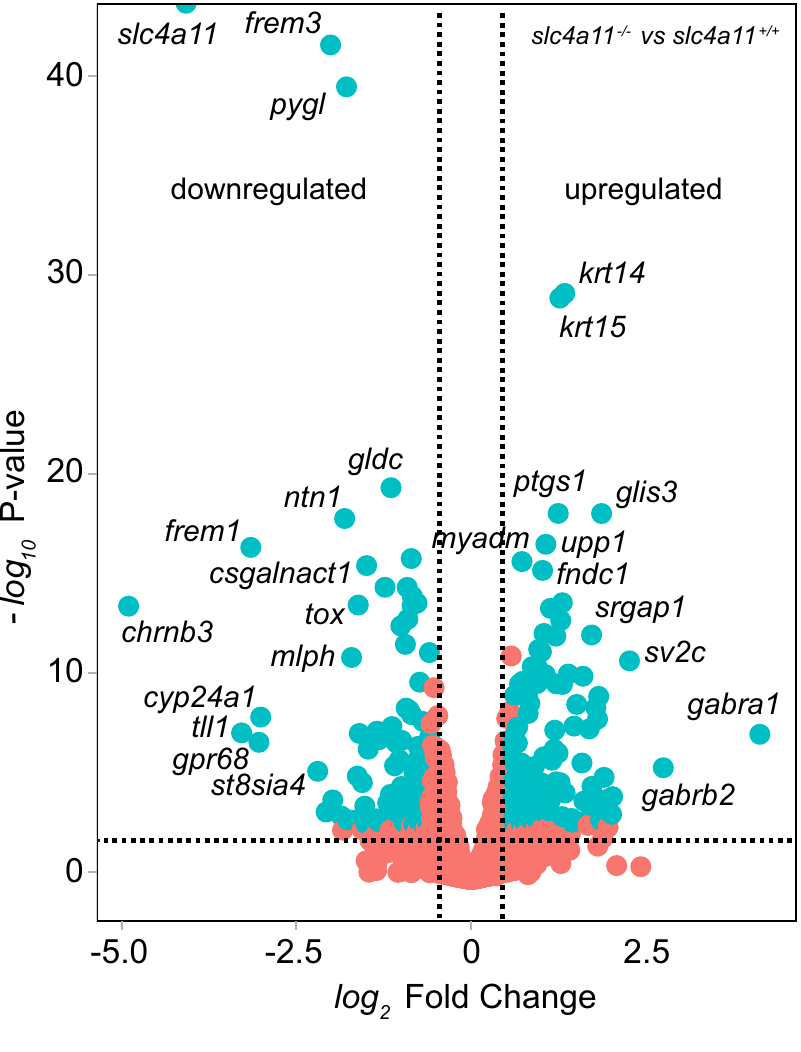
Figure 1 . Gene expression profiles for s lc4a11 + / + and slc4a11 −/− corneal RNA samples. Genes significantly down and up regulated in slc4a11 −/− cornea samples are indicated by blue dots. Genes with no significant differential expression are represented by red dots. Dashed lines indicate the boundaries for genes with significantly altered expression. The x-axis represents fold change of gene expression, and the y-axis represents the magnitude of significance of the gene expression changes. Identified gene examples: slc4a11, solute carrier family member 11; f rem3 , fras 1 related extracellular matrix protein 3; ntr1 , netrin 1; pygl , prostaglandin endoperoxidase synthase 1; frem1 , fras 1 -related extracellular matrix 1; csgalnact1 , chondroitin sulfate N-acetylgalactosaminyltransferase-1; tox , thymocyte selection-associated high mobility group box; mlph , melanophilin; tll1 , tolloid-like protein 1; gpr68, G-protein-coupled receptor 68; st8sia4 , polysialyltransferase; upp1, uridine phosphorylase 1; ptgs1, liver glycogen phosphorylase 1; krt 14